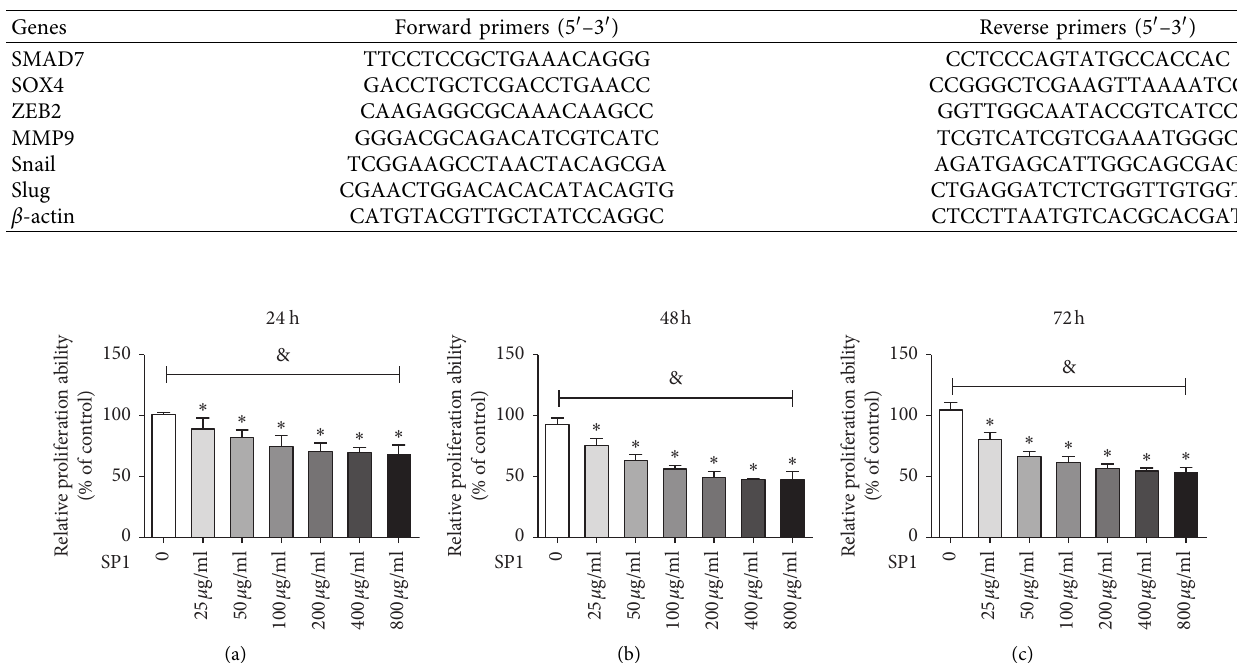
Table 1: qRT-PCR Primer sequence.